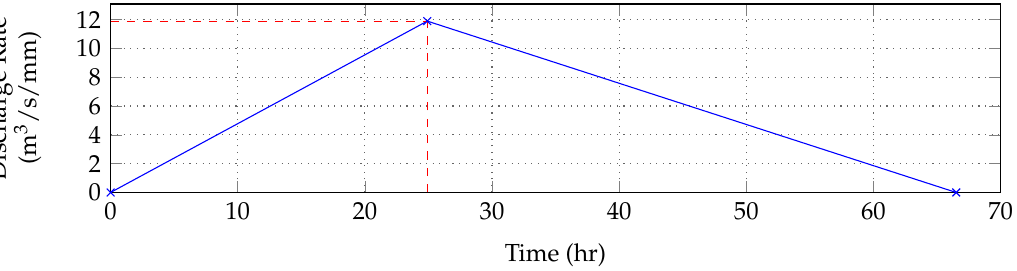
Figure 2. Triangular Unit Hydrograph (TUH) for a return period of T r = 20